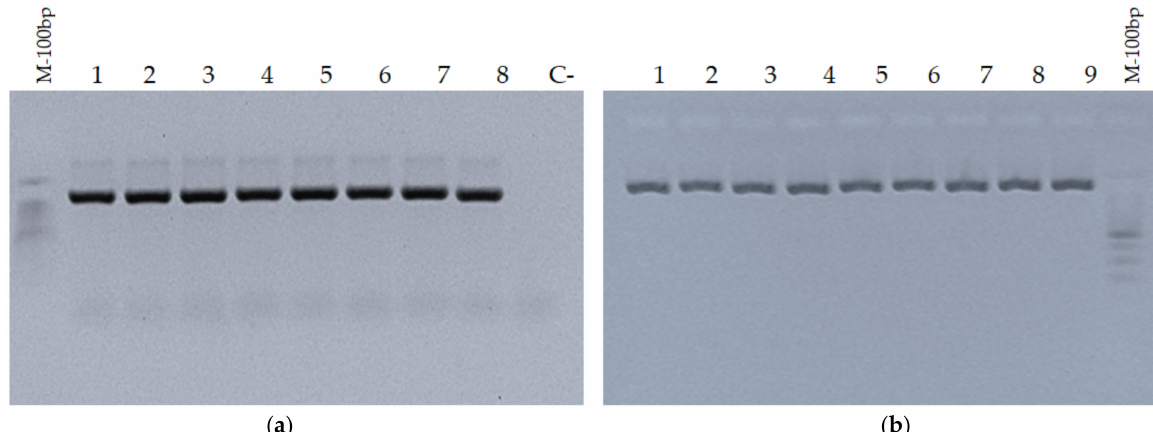
Figure 3. Amplification of mitochondrial markers: ( a ) Amplification of cytochrome b sequence (M, 100 bp marker; C-, negative control; 1–8: sample numbers). ( b ) Amplification of d-loop sequence (M, 100 bp marker; C-, negative control; 1–9: sample numbers).